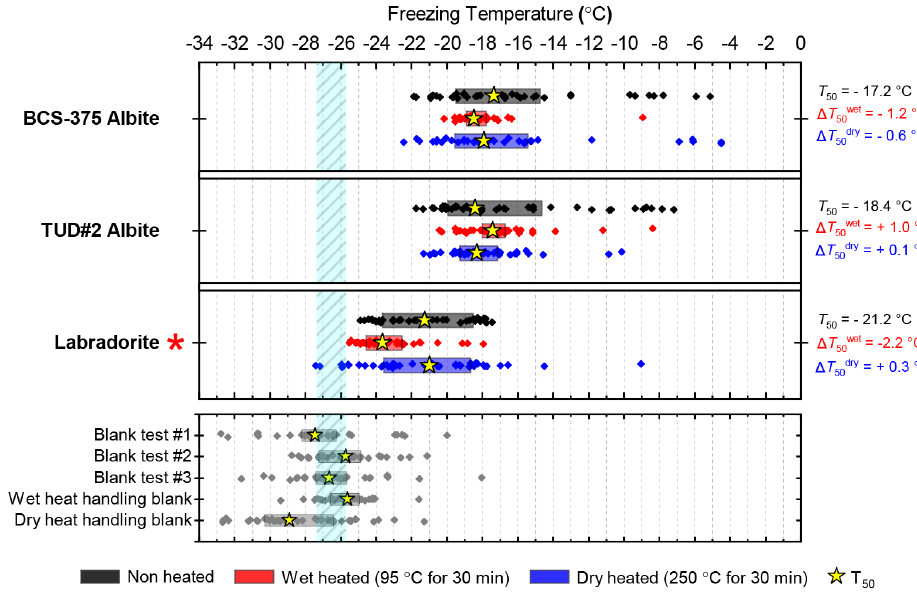
Figure 3. Boxplot showing freezing temperatures before (black) and after heat treatments (red for wet heat, blue for dry heat) for all plagioclase feldspar samples along with clean water blank and handling blank